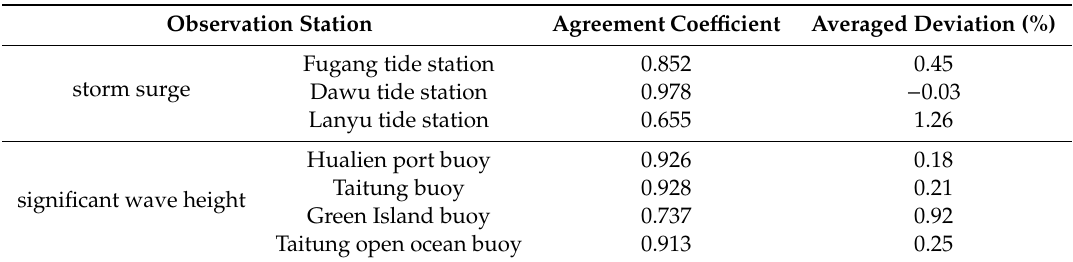
Figure 9. Comparisons of significant wave heights between model hindcasts and observations (Typhoon Nesat July 2017). Refer to Figure 5 for observation site locations. Table 1. Statistical results of the quantitative verification in Typhoon Meranti.